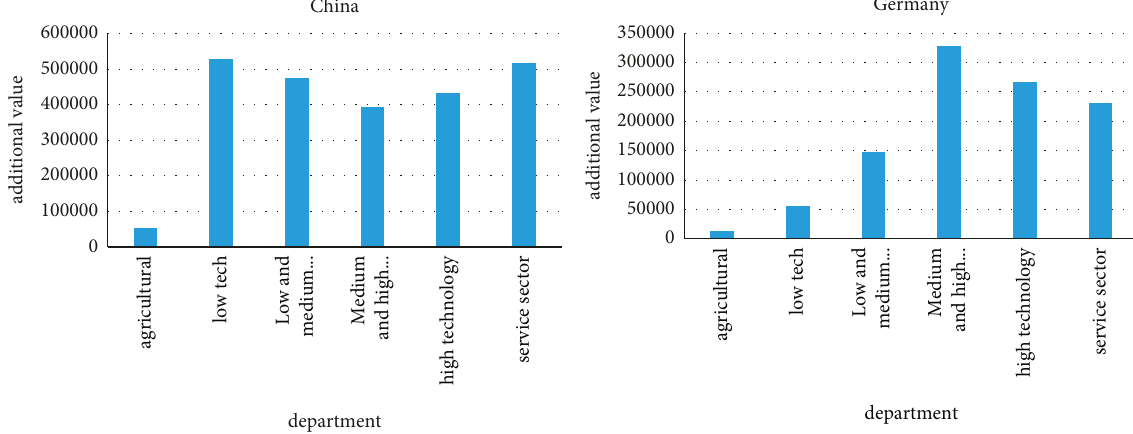
Figure 7: Export value-added structure of some Economies1.